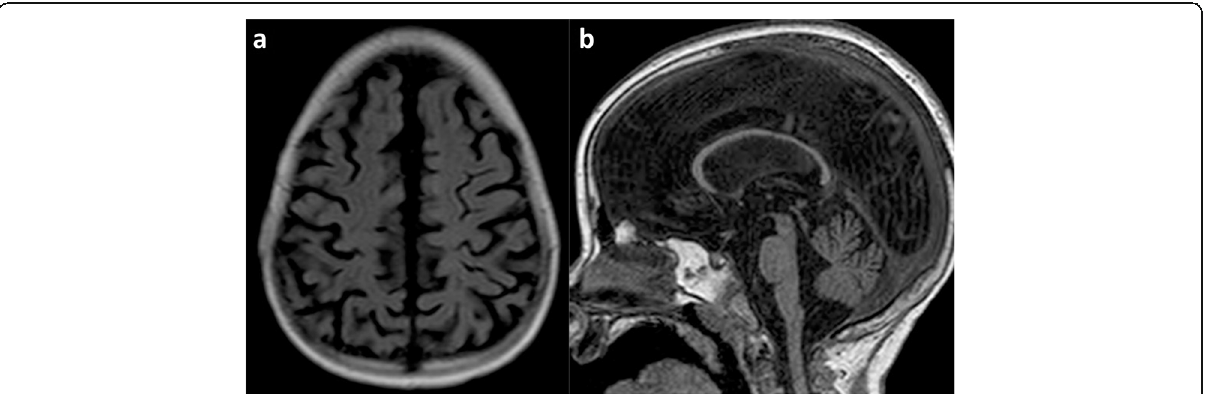
Fig. 19 a , b Generalised atrophy, of unknown cause, in a 5-year-old girl. Axial FLAIR image ( a ) demonstrates generalised atrophy without any regional predominance in the watershed distribution and there is no ulegyria. The midline sagittal T1 image ( b ) demonstrates that there is diffuse moderate thinning of the corpus callosum but also without any regional